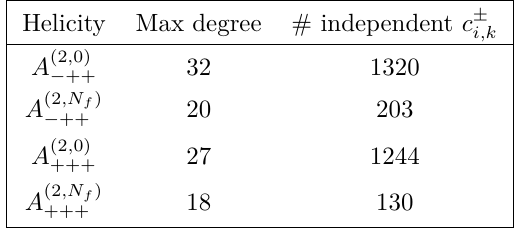
Table 2. Characterizing data for analytic expressions of master integrals, see eqs. (3.6) and (3.7). ‘Max degree’ is the highest polynomial degree across the different numerators c ± independent c ± ’ gives the dimension of the space of rational functions required to write all the c ± i,k closed under all photon permutations and sufficient to determine all the